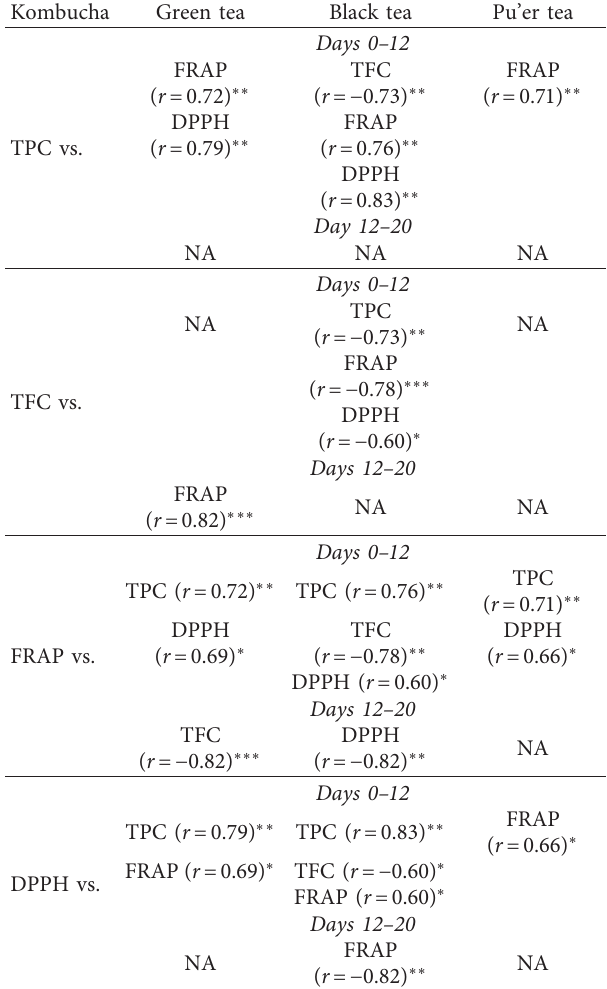
Table 2: Statistically significant correlations ( r ) between param- eters determined for kombucha fermented from different types of tea. Kombucha Green tea Black tea Pu’er tea Days